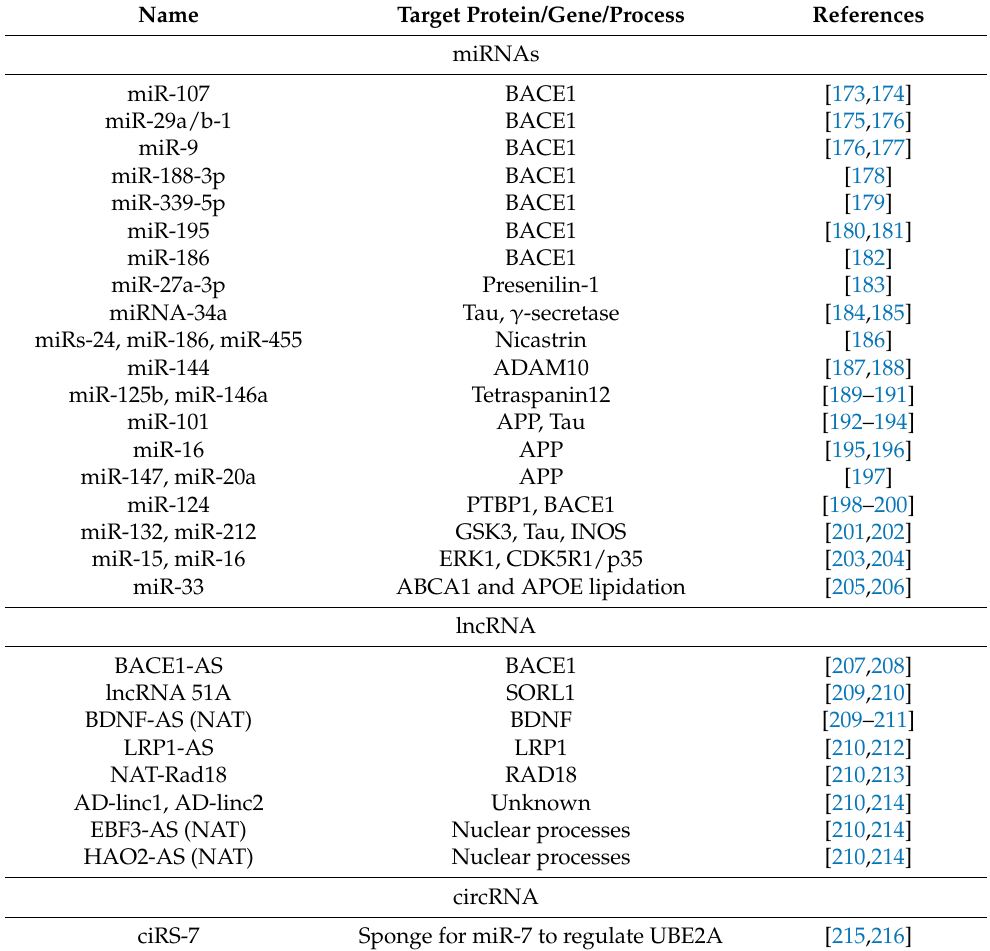
Table 4. Summary of ncRNAs involved in